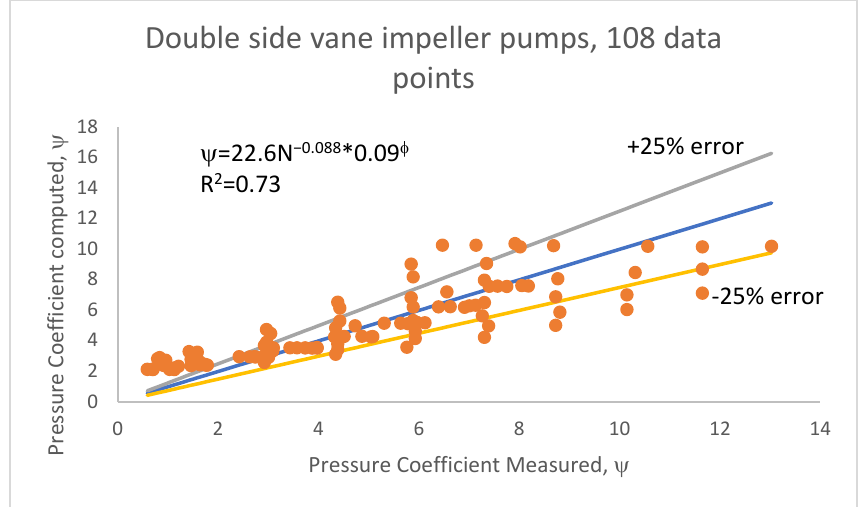
Figure 7. Pressure coefficient of double ‐ side vane impeller pump as computed by the correlation.